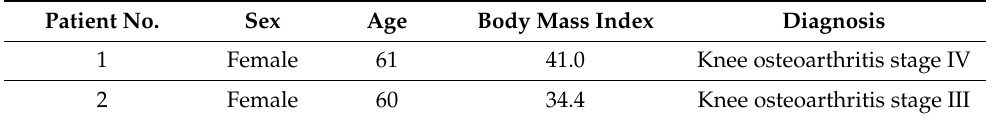
Table 2. General clinical data of menisci